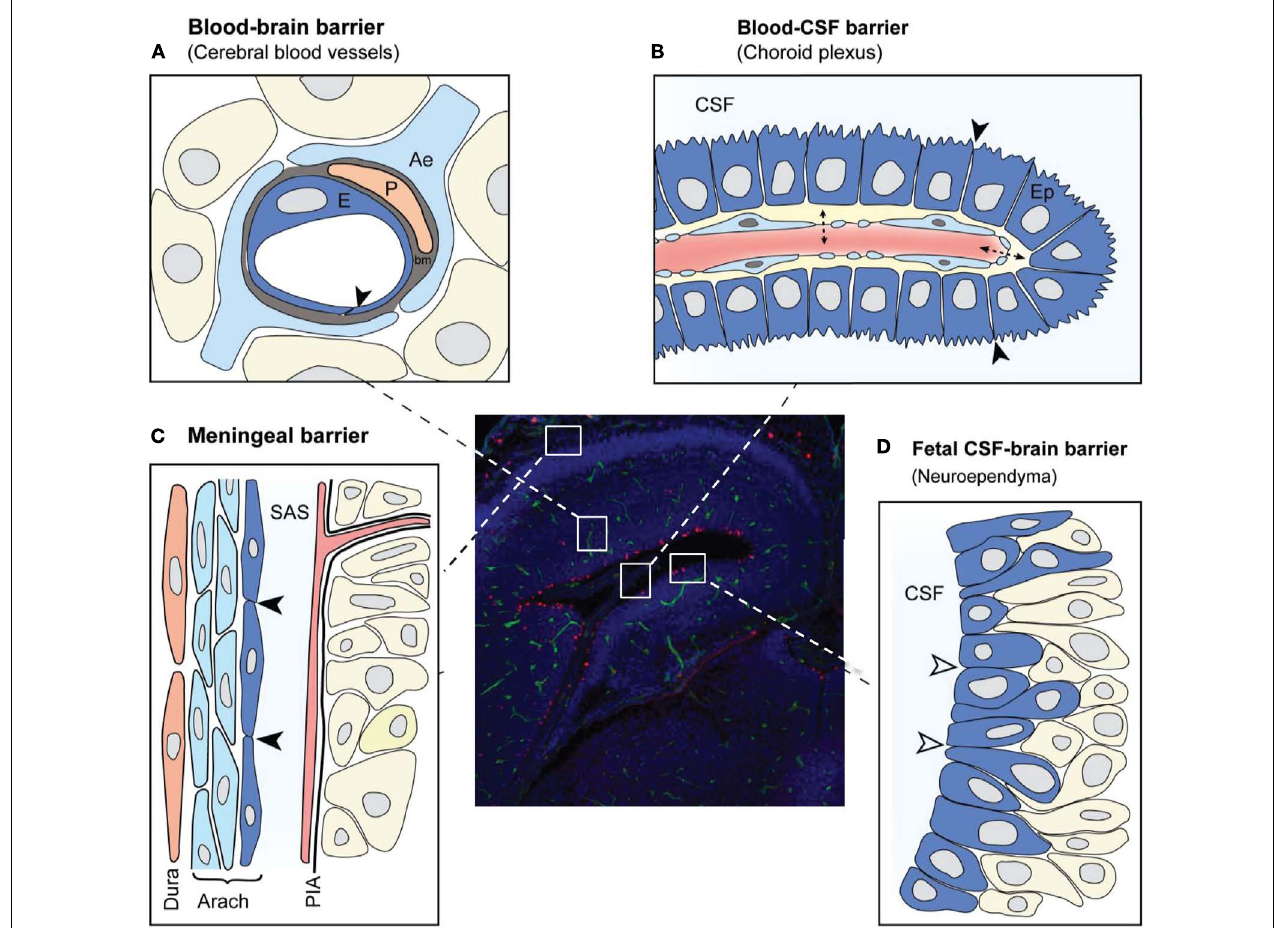
blood-CSF barrier, as the endothelial cells in the stroma are fenestrated.The meningeal barrier (C) is at the boarder of the arachnoid membrane (Arach) and the subarachnoid space (SAS).The fetal CSF-brain barrier (D) exists during early development, at the endfeet of the radial glial progenitors.This forms a barrier between the CSF and the developing parenchyma. Modified from Saunders et al.